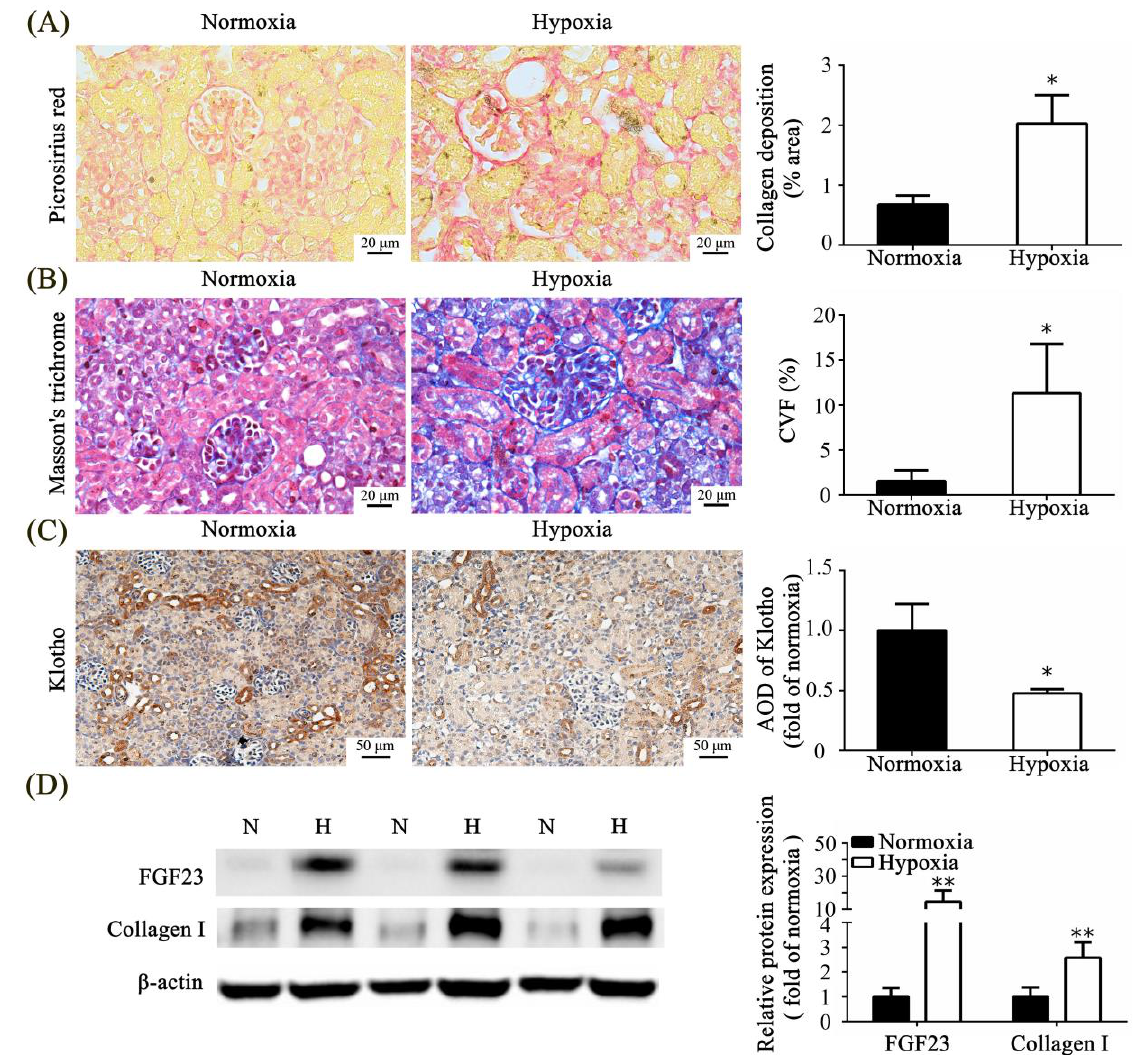
Figure 4. Neonatal hypoxia-induced kidney fibrosis. ( A ) Picrosirius red-stained images of the kidney tissue show collagen (red) under 400 × magnification (scale bar, 20 µ m) and quantification. ( B ) Masson trichome-stained images of the kidney tissue show fibrosis (blue) under 400 × magnification (scale bar, 20 µ m) and the CVF. ( C ) Representative images of klotho immunohistochemical staining in the kidney tissue under 200 × magnification (scale bar, 50 µ m) and quantitative analysis. ( D ) Representative images of FGF23 and collagen I immunoblotting in the kidney and quantitative analysis. The values are presented as mean ± standard deviation. * p < 0.05, ** p < 0.01, versus the normoxic group. The p -values were estimated via Mann–Whitney U test ( n = 4–8). N, normoxia; H, hypoxia; CVF, collagen volume fraction; FGF23, fibroblast growth factor